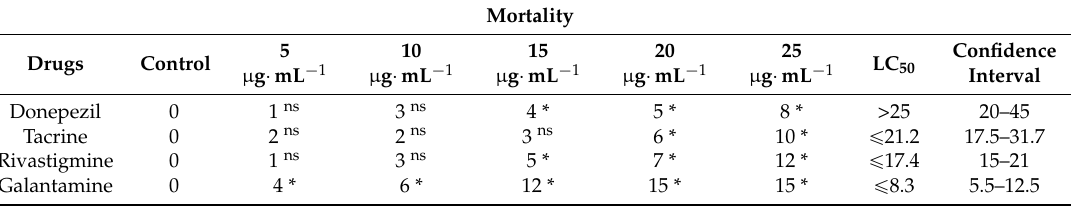
Table 1. Mortality (%) and LC 50 of D. tigrina submitted to 4 different drugs and 5 concentrations after 24 h of